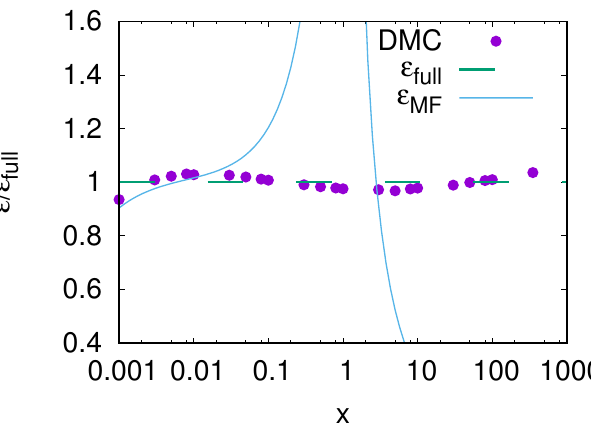
Figure 2: DMC energies per particle (symbols), ε line), all in scattering length units, divided by ε Here, ε denotes an energy per